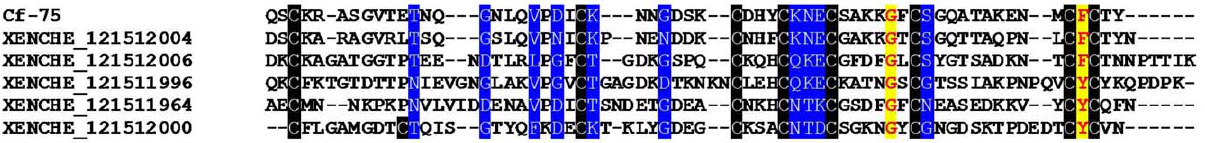
Figure 4. The deorphanized 8-Cys family of flea salivary peptides. (A) ClustalW alignment indicating the cysteine residues in black background, the identical Gly as well as the conserved Phe and Tyr in yellow background, and remaining conserved amino acids in blue background. The numbers above the sequence indicate the eight conserved cysteines. The signal peptide region is not shown. The sequences identified in this work are named Cf- followed by the number of the originating contig from File S1. The sequences derived from GenBank are recognized by the first three letters of their genus name, followed by the first three letters of the species name, followed by the gi| accession number.